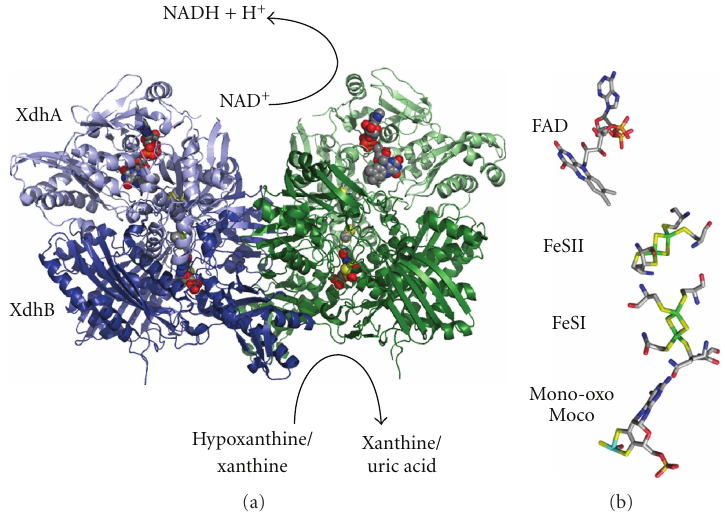
Figure 2: Overall structure and cofactor arrangement of R. capsulatus XDH. R. capsulatus XDH forms an ( αβ ) 2 heterotetramer. The XdhA subunits are drawn in light green and light blue and the XdhB subunits in dark green and dark blue. The [2Fe-2S] and FAD cofactors of XdhA and the Moco of XdhB are shown as space-filling models. The Moco is deeply buried in the XdhB subunit being only accessible through a substrate-binding channel. Also shown is the coordination of Moco and FeSI, FeSII and FAD at the active site of R. capsulatus XDH and the reaction catalyzed by XDH. The structures were generated using the coordinates from the Protein Data Bank (accession number 1JRO).